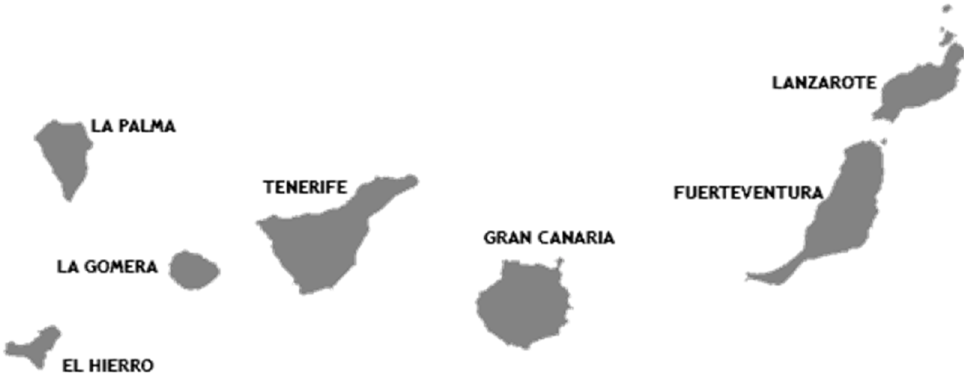
Figure 1. The Canary Islands archipelago, Spain (latitude, longitude: 28.291565, − 16.629129).